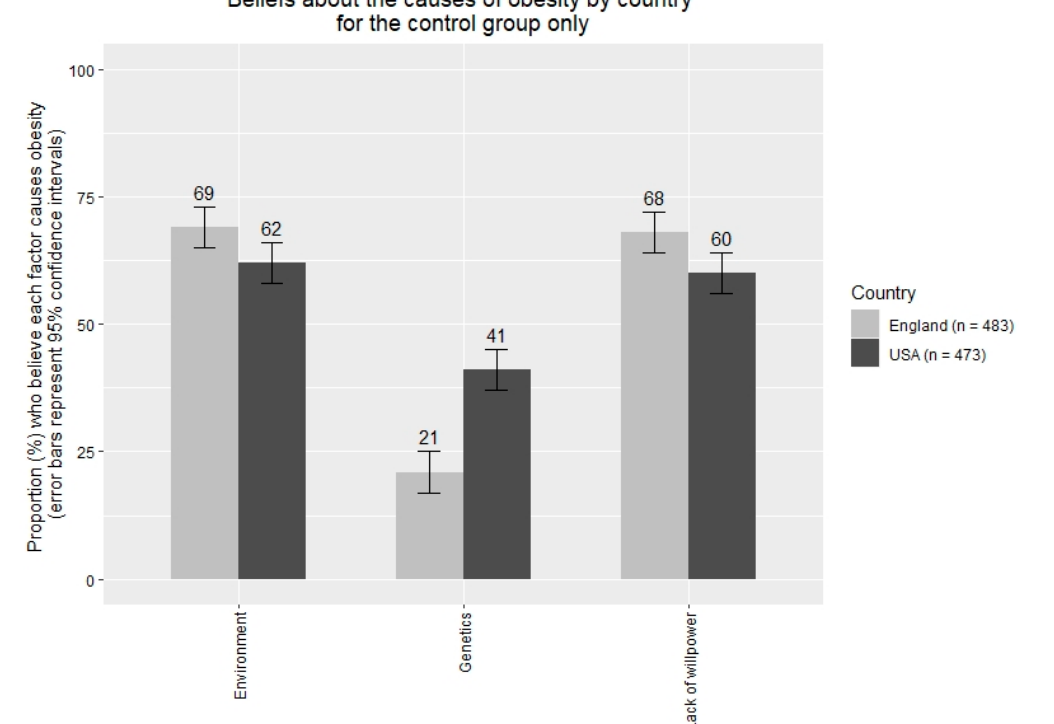
Figure 2. Study 2: Beliefs about the causes of obesity by country.